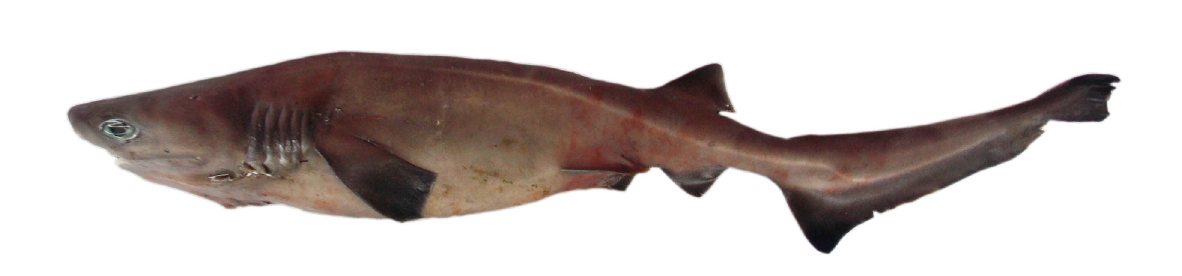
Fig. 5. Lateral view of Hexanchus griseus (PUMB 3528, 770 mm TL, female) from Andaman